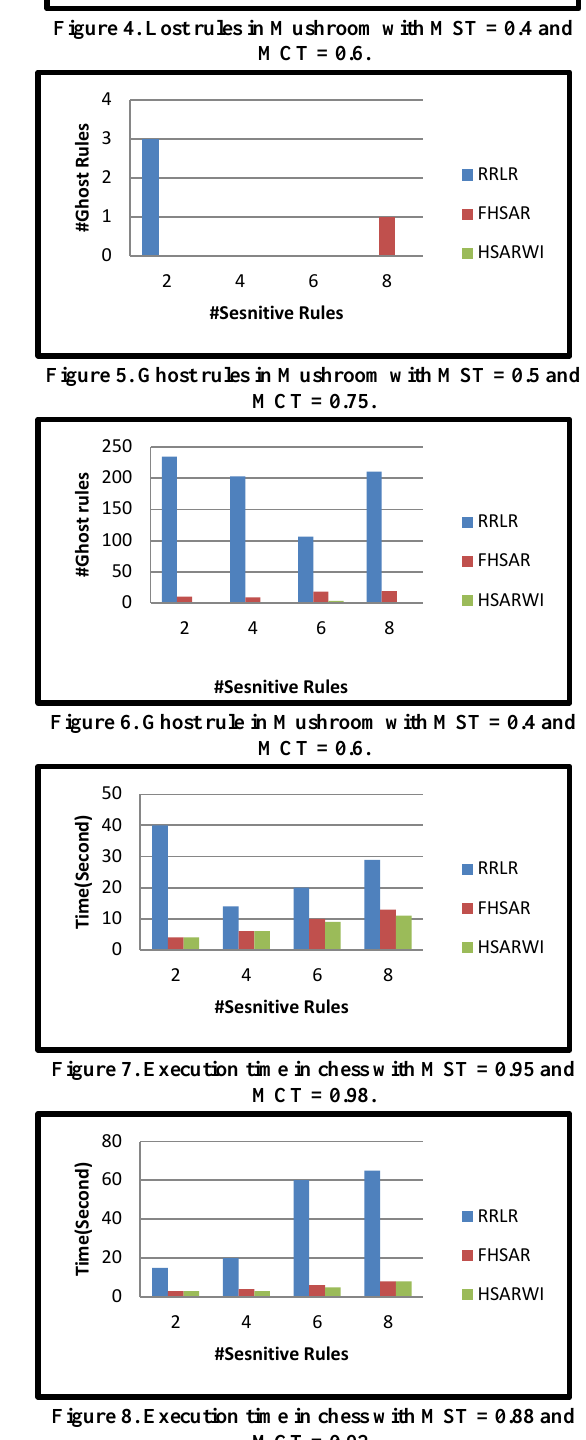
Figure 4. Lost rules in Mushroom with MST = 0.4 and MCT = 0.6.